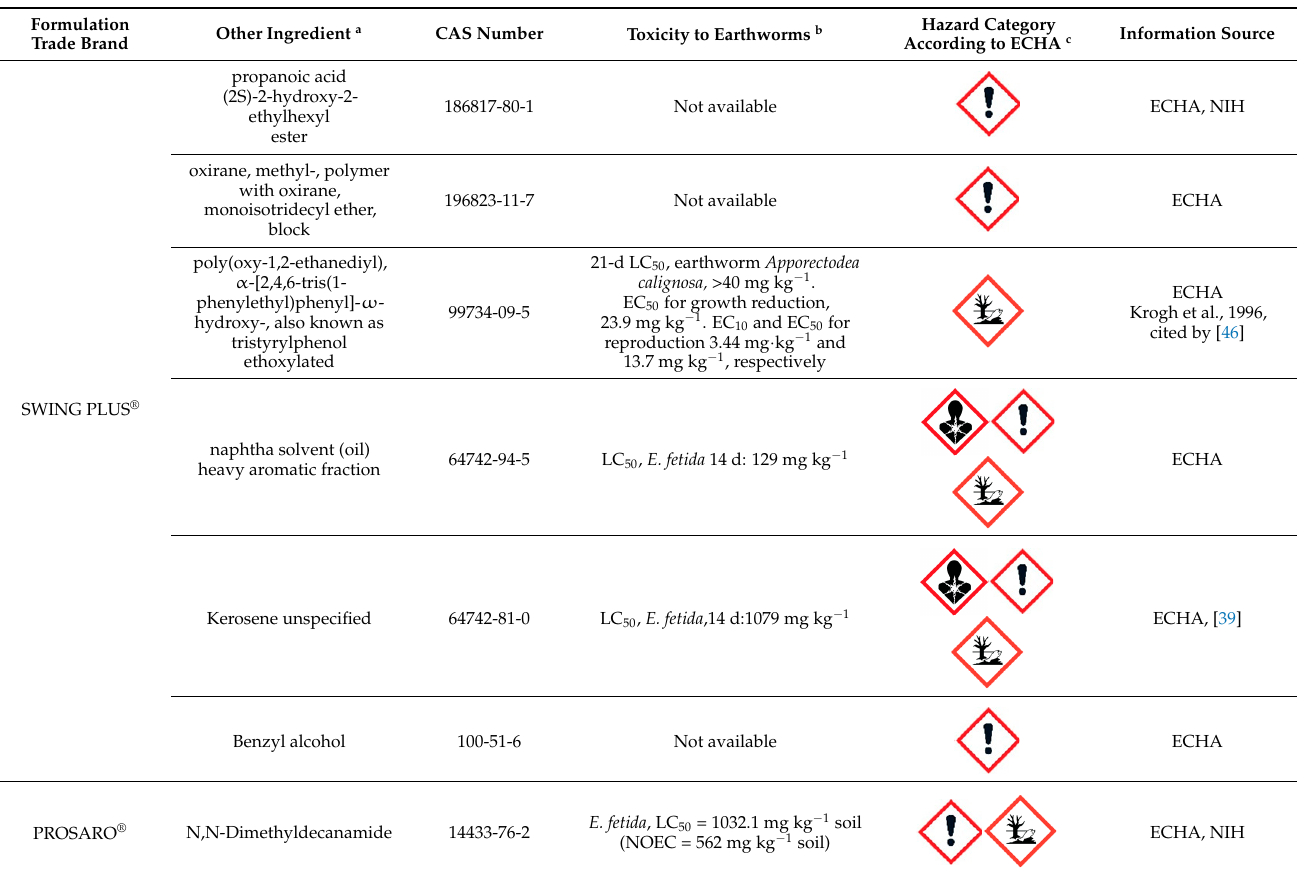
Table 4. The hazards of other ingredients declared in two commercial fungicide formulations.